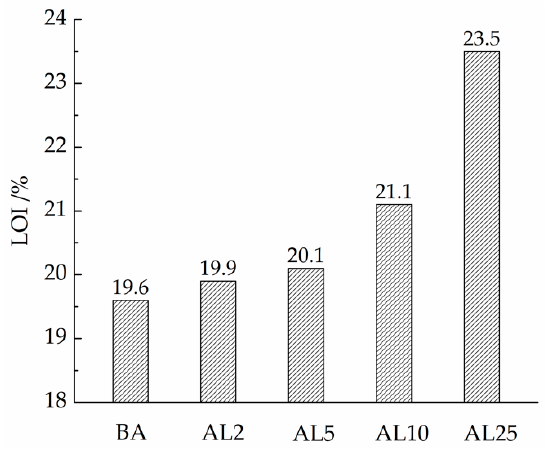
Figure 5. Limiting oxygen index (LOI) of asphalt binders.